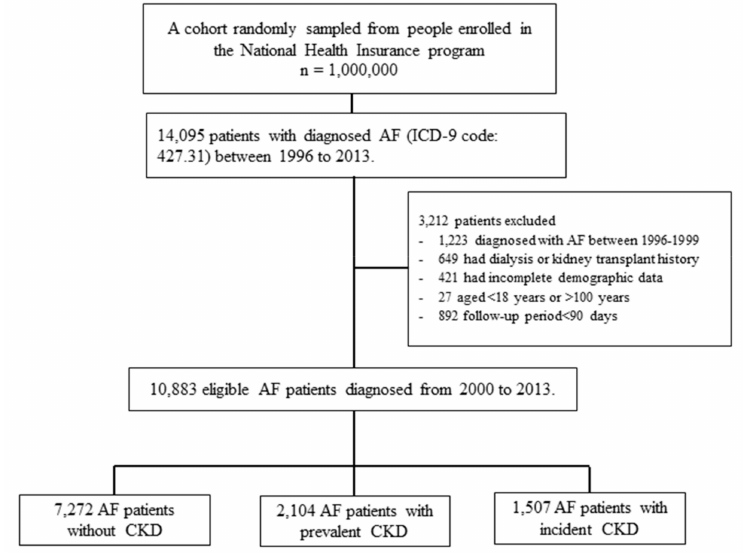
Figure 1. Flowchart of patient selection processes for incident atrial fibrillation (AF) patients with non-chronic kidney disease (CKD), prevalent CKD and incident